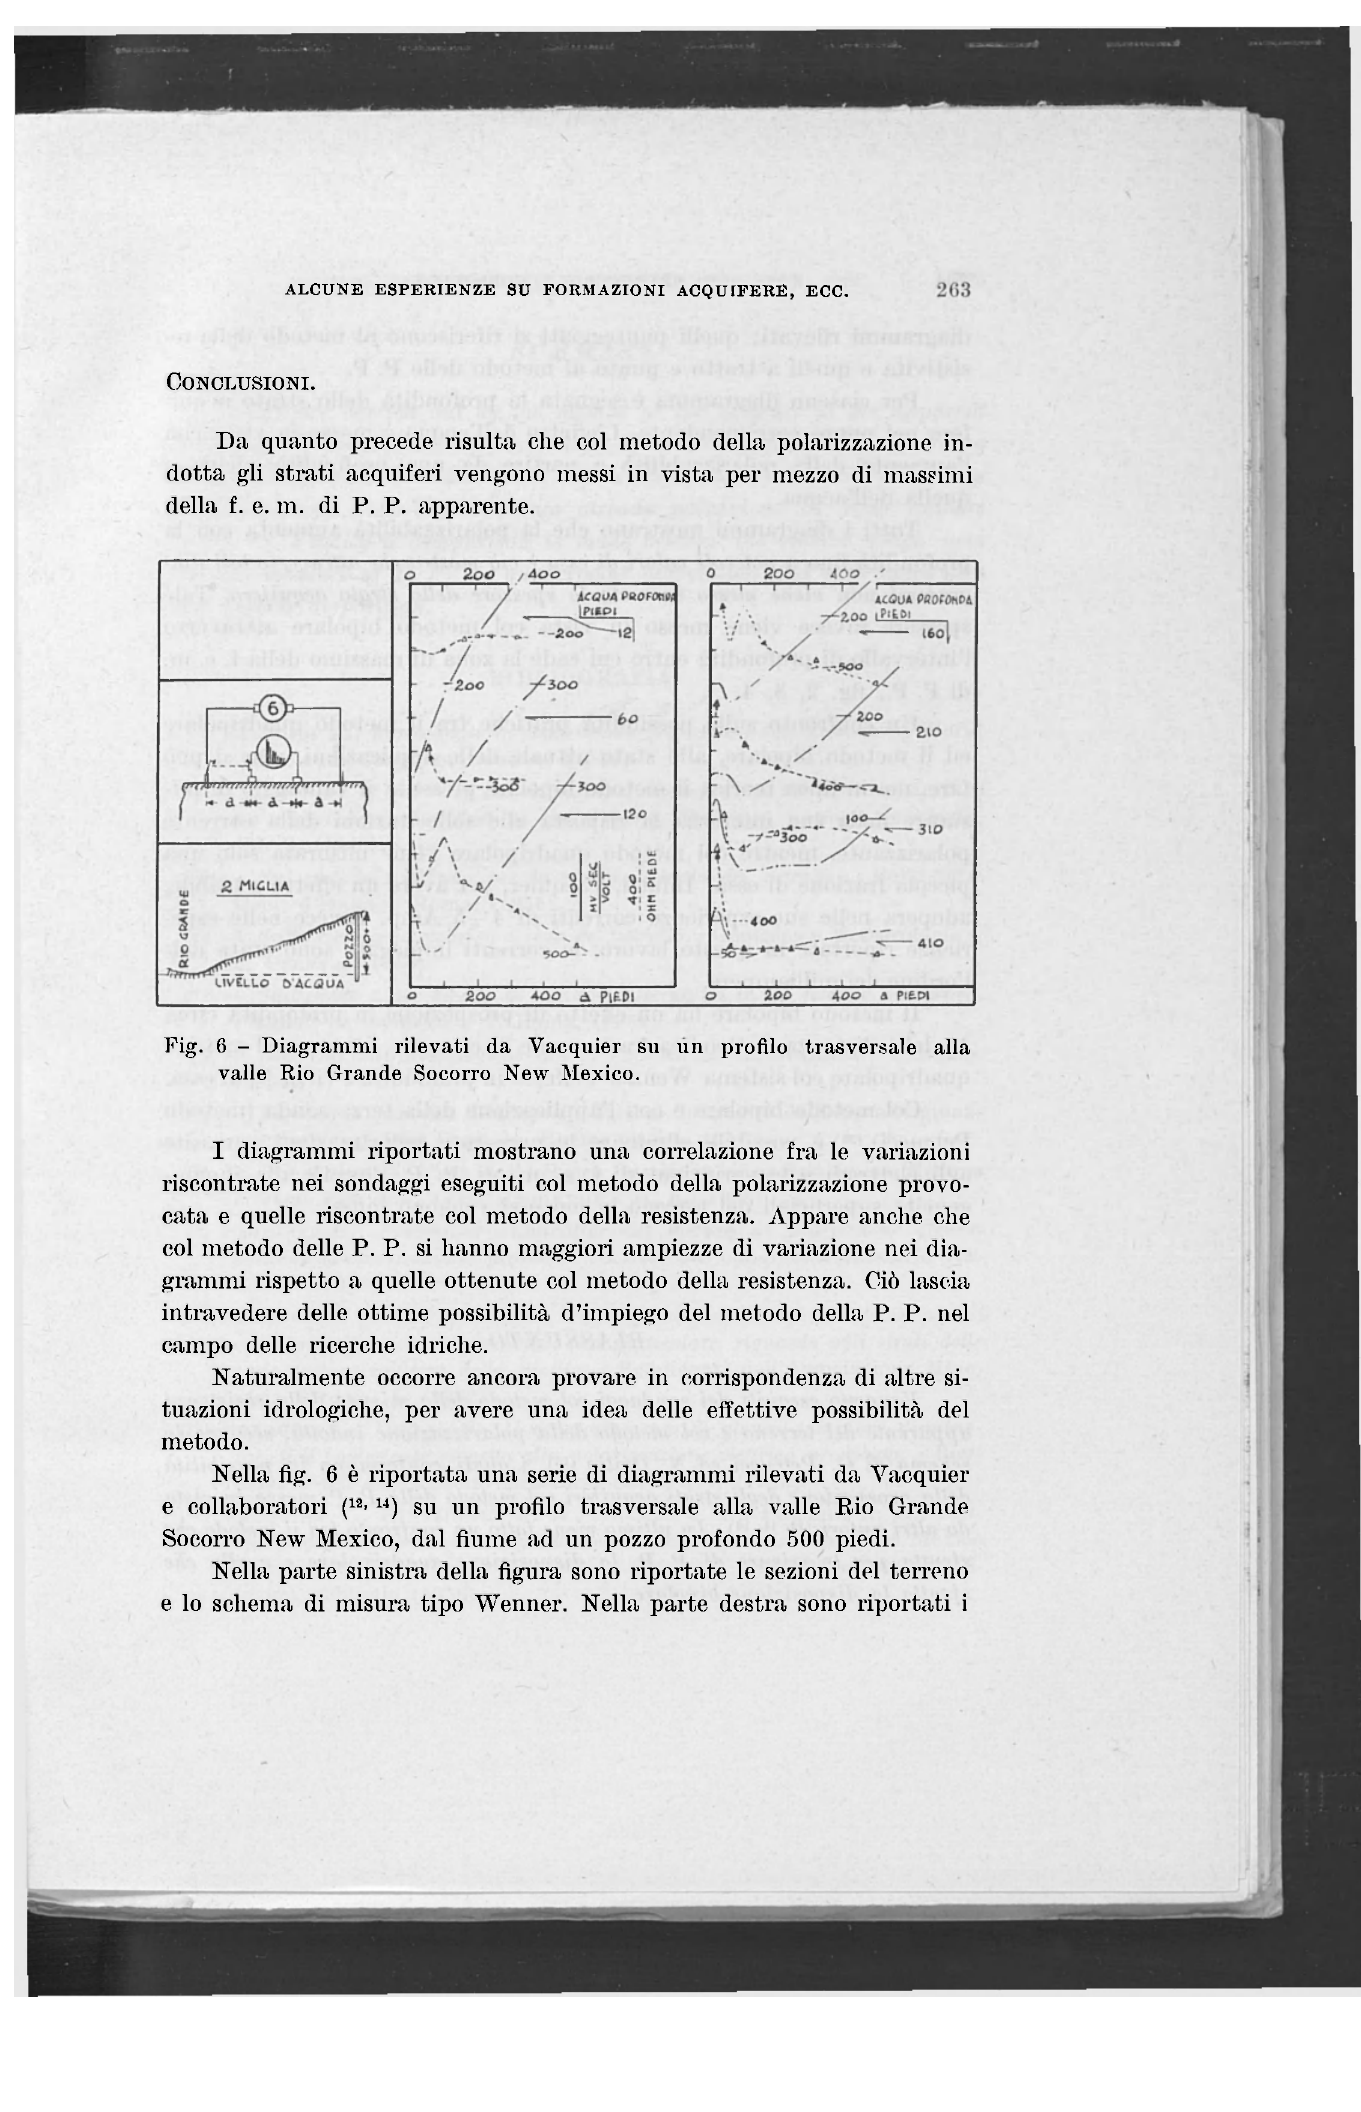
Fig. 6 - Diagrammi rilevati da Vacquier su un profilo trasversale alla valle Rio Grande Socorro New